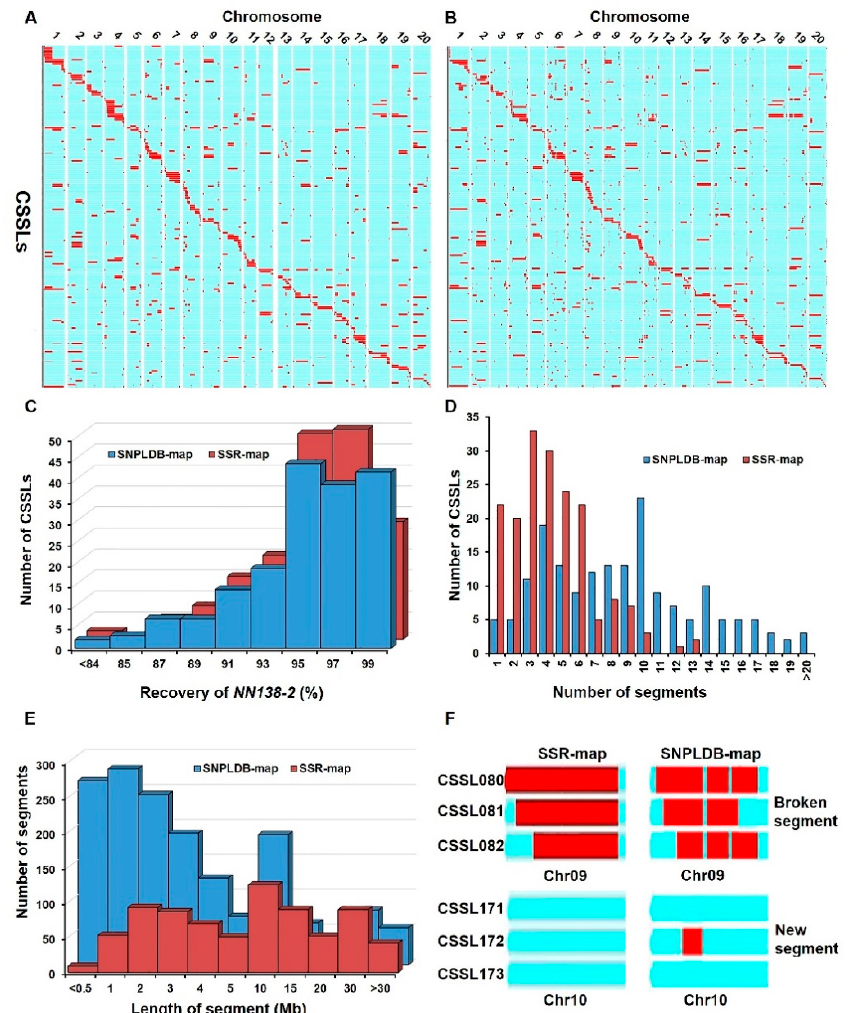
Figure 1. Molecular characteristics of SojaCSSLP5 derived from NN1138-2 and N24852 . ( A ) The physical map of SojaCSSLP5 genotyped by 182 SSR markers (SSR-map). ( B ) The physical map of SojaCSSLP5 genotyped by 1366 SNPLDB markers (SNPLDB-map). ( C ) The frequency distribution of NN1138-2 -recovery rate in SojaCSSLP5. ( D ) The frequency distribution of wild segment number per line in SojaCSSLP5. ( E ) The frequency distribution of wild segment length in SojaCSSLP5. ( F ) The SSR-segment broken into new SNPLDB segments. In ( A , B , F ), the light turquoise and red bars denote the NN1138-2 and N24852 segments, respectively. Table 1. SSR and SNPLDB linkage maps of SojaCSSLP5.